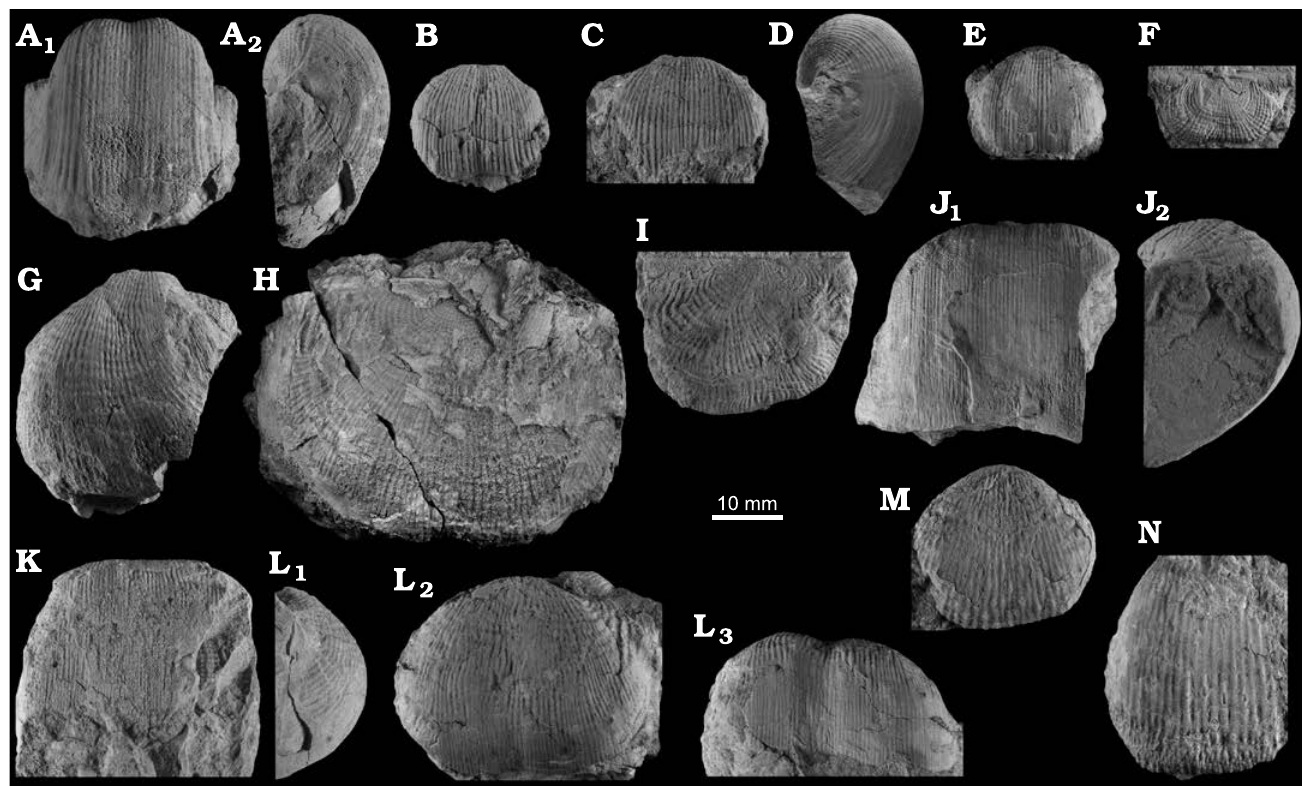
Fig. 11. Productidae from the Brigantian (uppermost Visean) of Ricklow Quarry, near Monyash, Derbyshire, UK (localities RCC-, RCK-; Fig. 3). A – F . Antiquatonia insculpta (Muir-Wood, 1928). A . MPUM11938 (RCC1B-9) in anterior (A 1 ) and lateral (A 2 ) views. B . MPUM11939 (RCC3-15a) in antero-ventral view. C . MPUM11940 (RCC42-26) in antero-ventral view. D . MPUM11941 (RCC110-1b) in lateral view. E . MPUM11944 (RCC2-25) ventral valve in ventral view. F . MPUM11947 (RCC128-2) dorsal valve interior and external cast. G , H . Dictyoclostus pinguis (Muir-Wood, 1928). G . MPUM11950 (RCC54-11) ventral valve in ventral view. H . MPUM11951 (RCK15-63a) dorsal valve external cast. I – K . Pugilis cf. kilbridensis (Muir-Wood, 1928). I . MPUM11956 (RCC128-3) dorsal valve interior and external cast. J . MPUM11955 (RCC54-4) ventral valve in anterior (J 1 ) and lateral (J 2 ) views. K . MPUM11954 (RCC2-47) ventral valve in anterior view. L . Pugilis cf. scotica (Sowerby, 1814), MPUM11958 (RCC2-41) in lateral (L 1 ), ventral (L 2 ), and anterior (L 3 ) views. M , N . Buxtonia scabricula (Sowerby, 1814). M . MPUM11959 (RCC1B-13) in ventral view. N . MPUM11960 (RCC35A-11a) in ventral